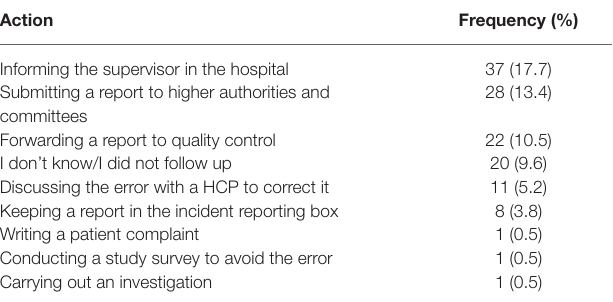
TABLE 6 | Causes of MEs and their frequency. Causes of MEs